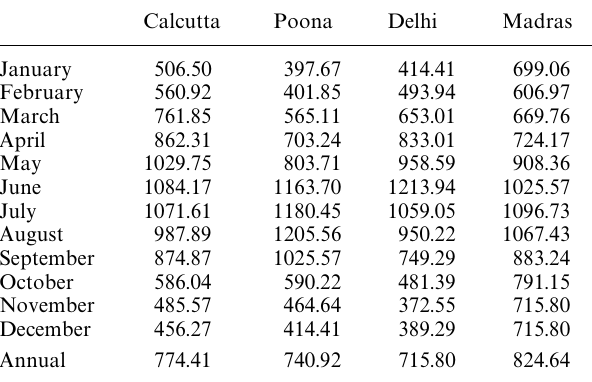
Table 1. Location of the four stations Stations